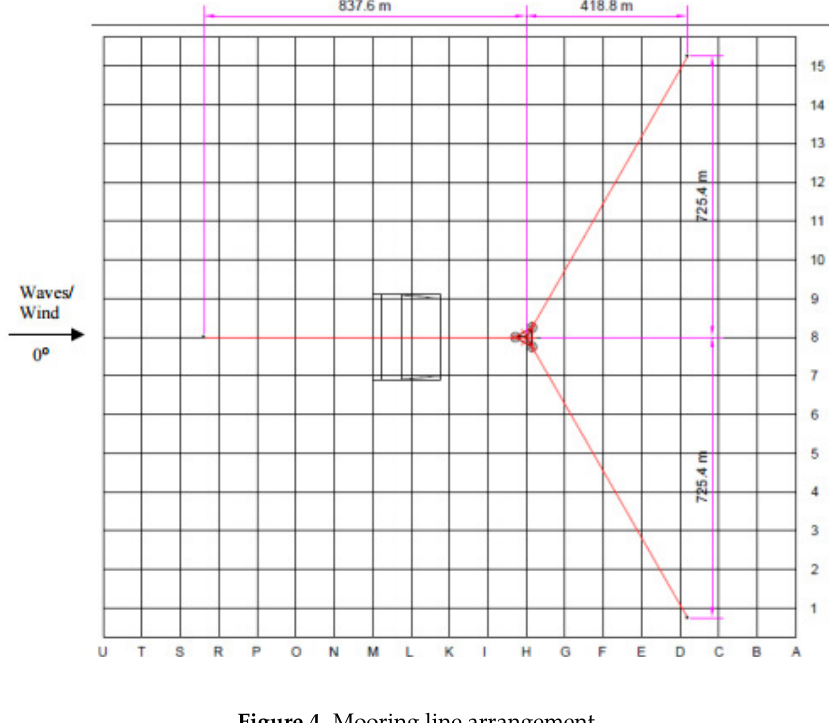
Figure 4. Mooring line arrangement. Table 3. The OC4-DeepCwind floating system geometry and structural properties. SWL, still water level; CM, center of